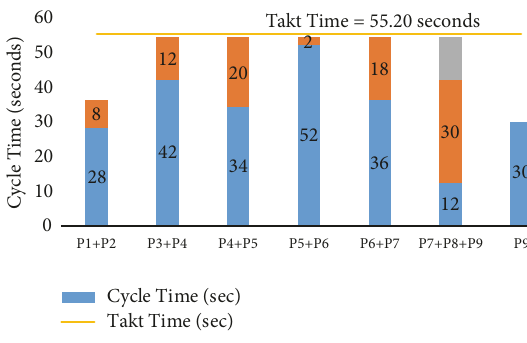
Figure 3: Future VSM.